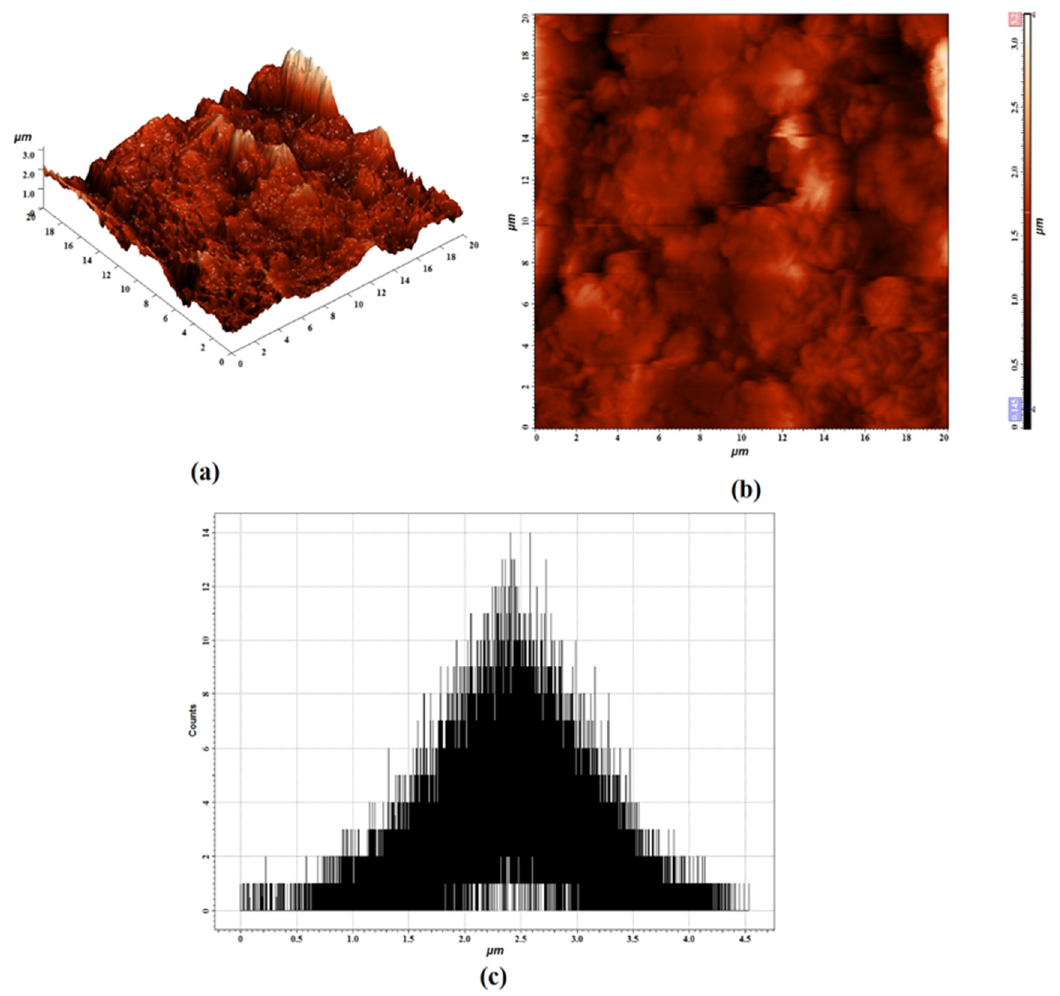
Figure 5. Surface morphology analysis of machined specimen under the factors of trial 26: ( a ) Three dimensional view; ( b ) Two dimensional view, and ( c ) Histogram analysis .